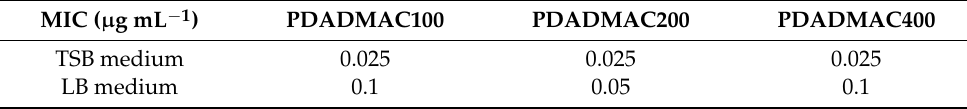
Table 1. MICs for polycations of various molecular